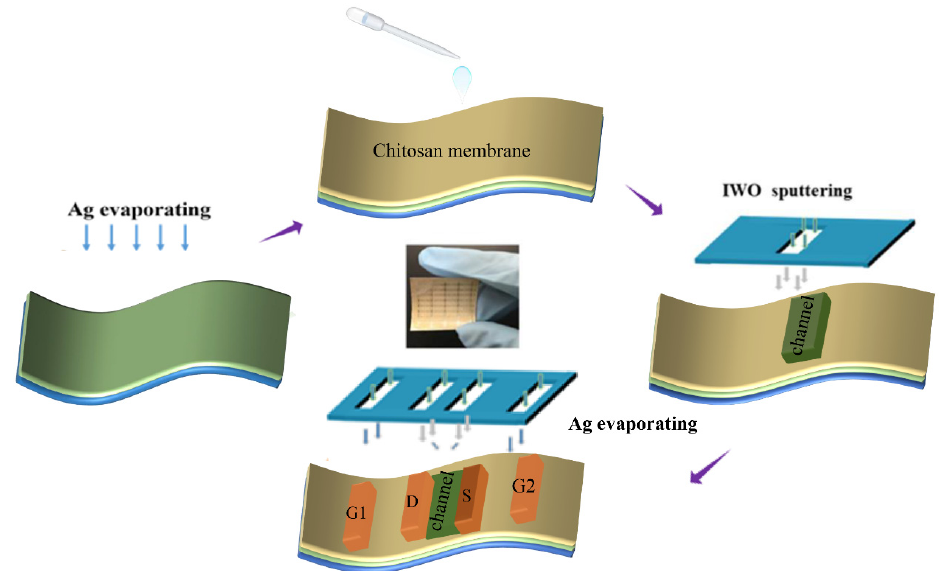
Figure 1. Fabrication process for flexible multi-gate IWO-based TFTs with chitosan gate dielectric on paper.